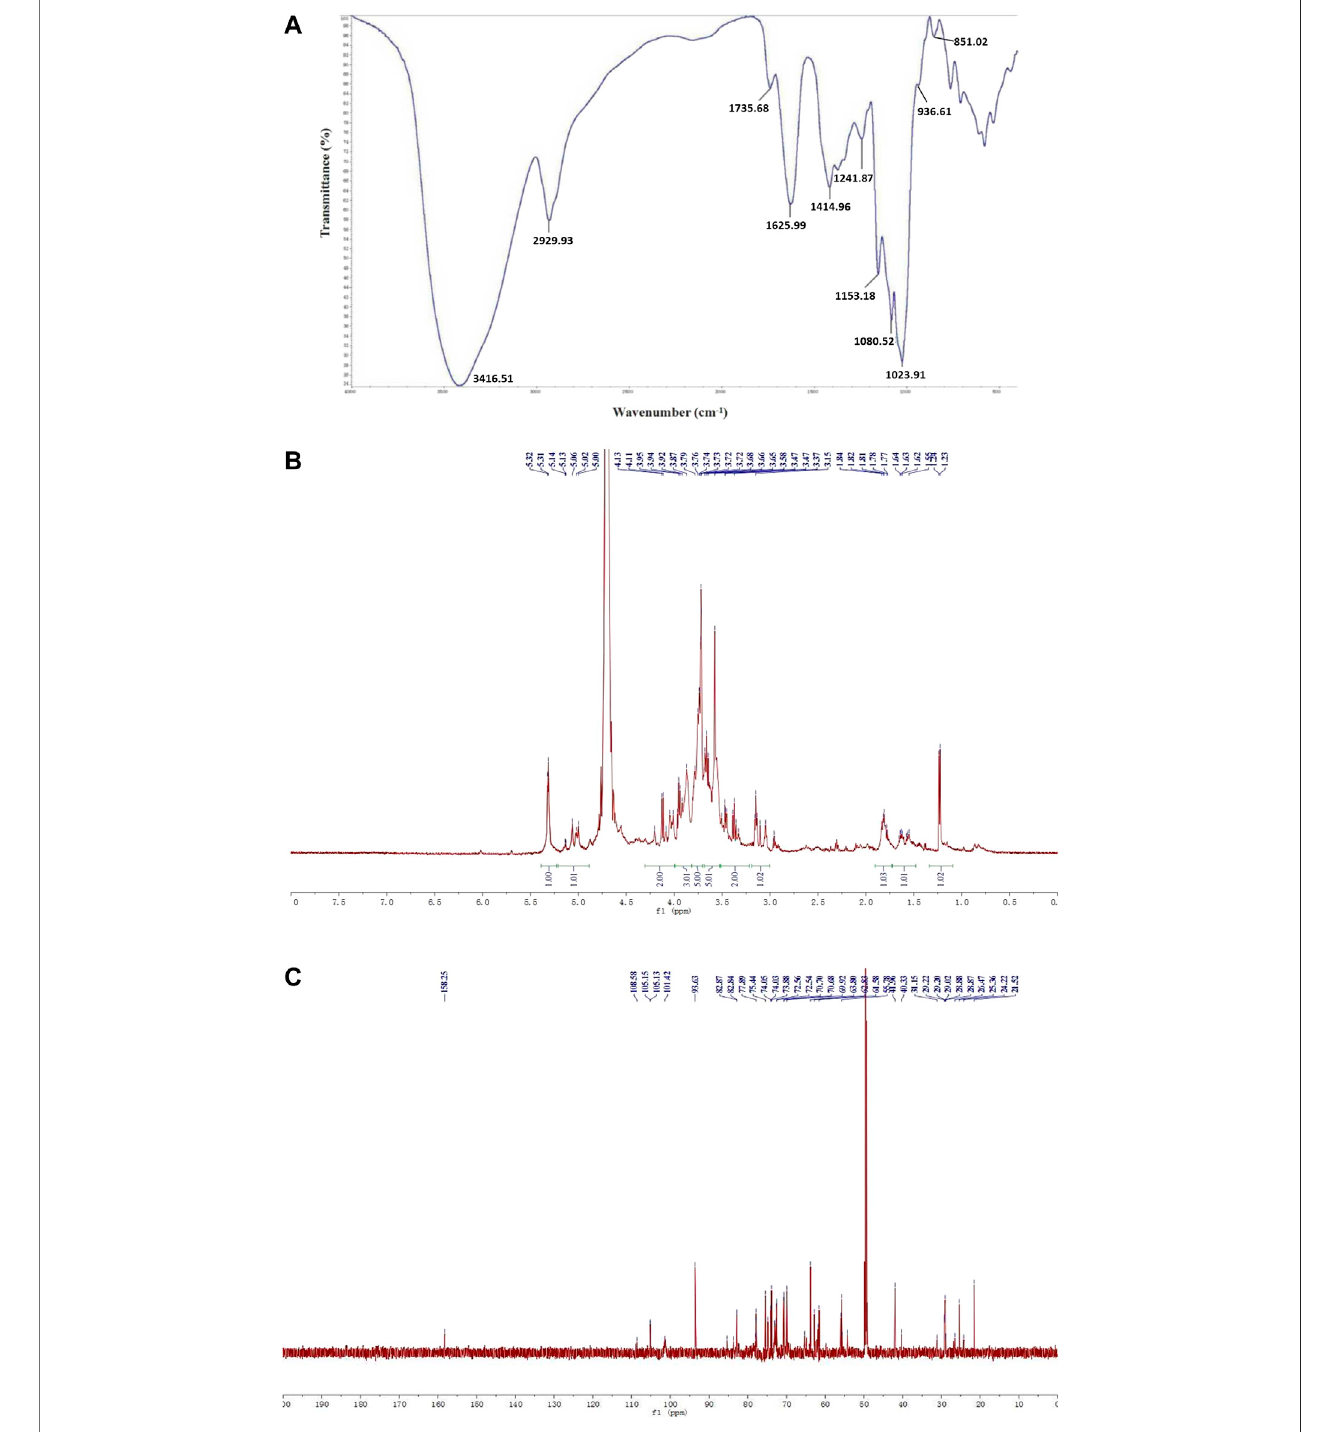
FIGURE 2 | Structural characterization of WGP. FT-IR spectrum with the range of 4,000 – 400 cm − 1 (A) and 1 H NMR (B) , 13 C NMR (C) spectra were used to characterize WGP structure.